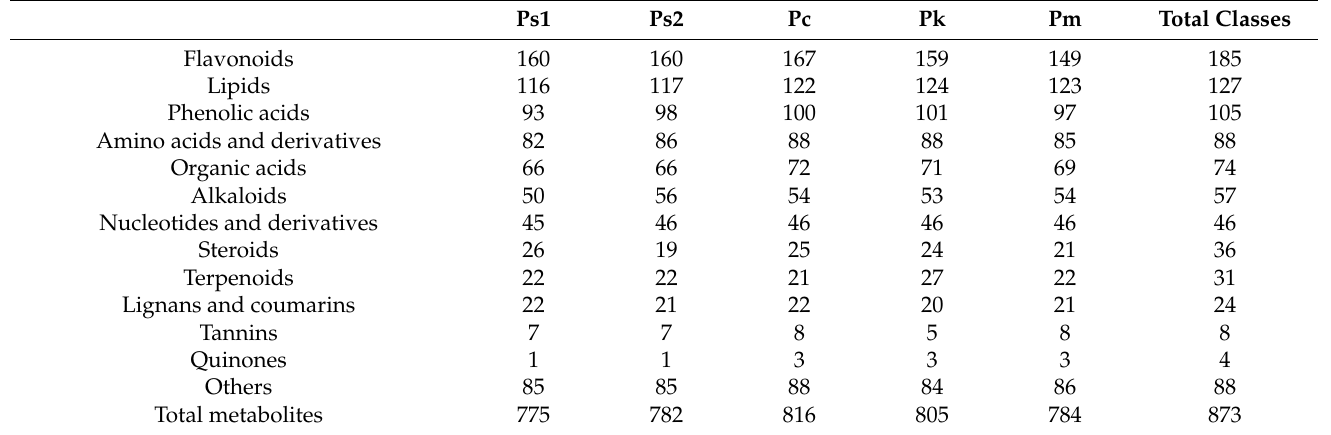
Table 1. Classification of the metabolites detected in five seed samples. Ps1 Ps2